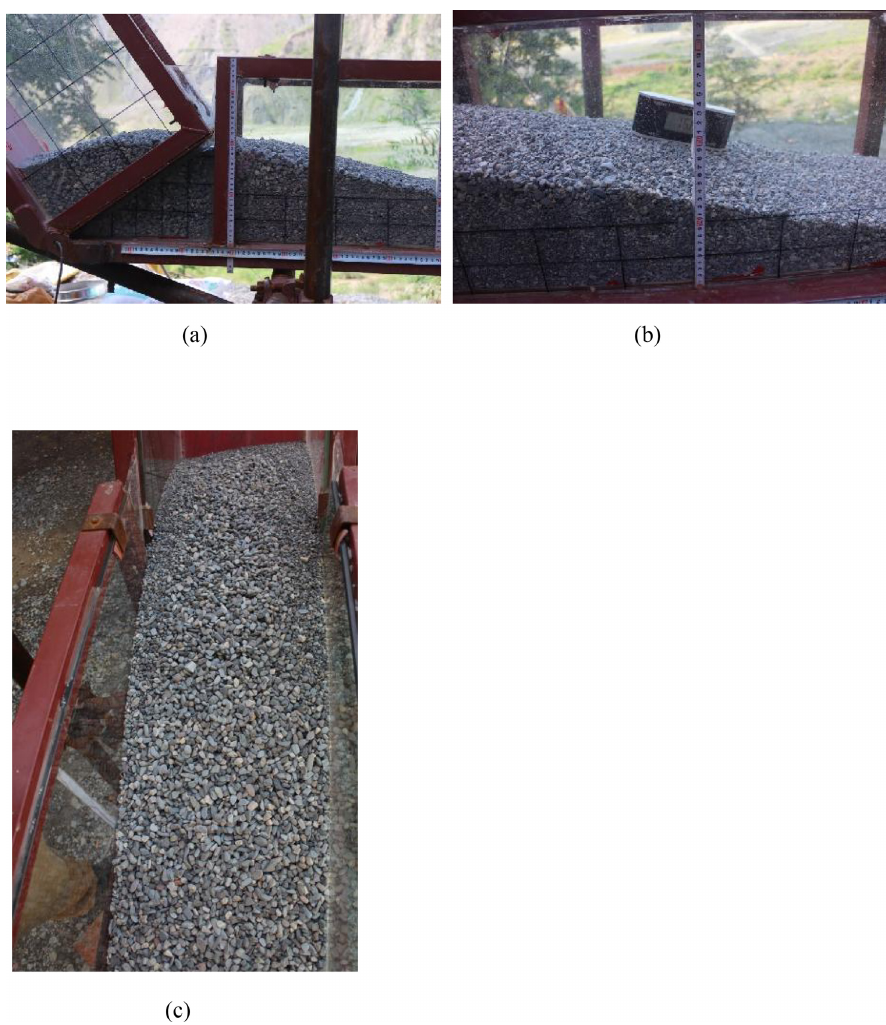
Figure 17. (a) Deposition at the rear of the deposit. (b) Deposition at the front of the deposit. (c) Front view of the deposition (two types of